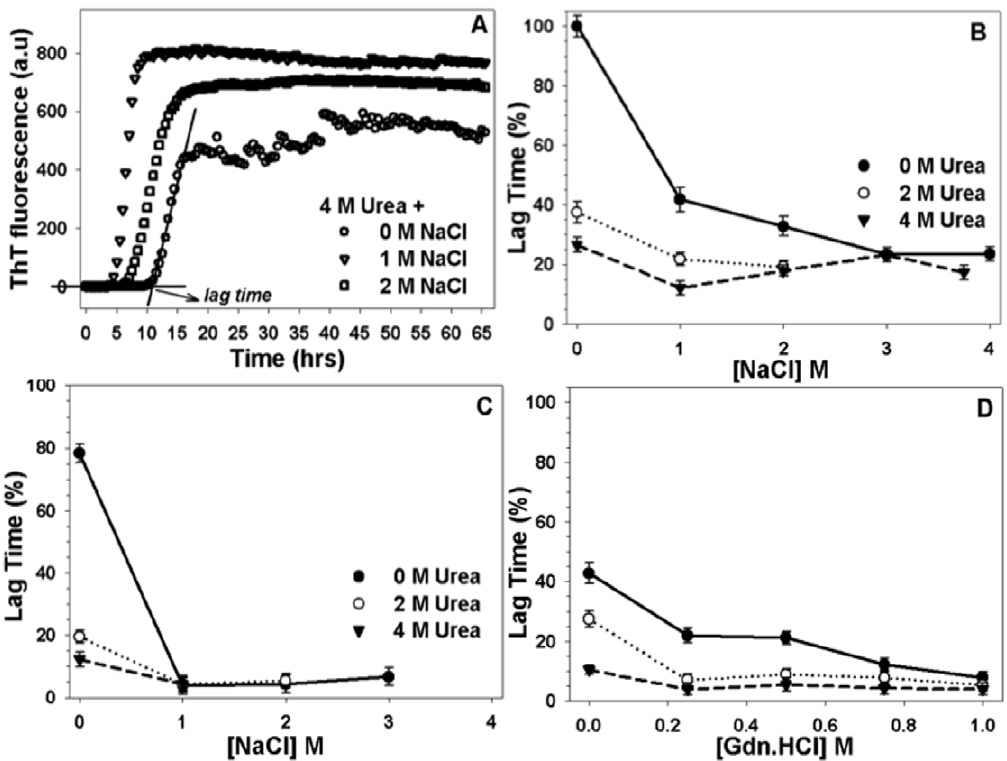
Figure 1. Kinetics of insulin fibrillation. Panel A shows representative sigmoidal curves of insulin fibrillation obtained at increasing NaCl concentrations in the presence of 4 M urea pH 7.4. The profiles are a plot of ThT emission max at 482 nm with respect to time. Panel B shows changes in the lag time of insulin fibrillation obtained from ThT plots at increasing NaCl concentrations in the presence of either 0 M (circles), 2 M (inverted triangles) or 4 M urea (squares) at pH 7.4. Panel C exhibits changes in the lag time with increasing NaCl concentrations in the presence of either 0 M (circles), 2 M (inverted triangles) or 4 M urea (squares) at pH 2. Panel D shows changes in the lag time with increasing Gdn.HCl concentrations in the presence of either 0 M (circles), 2 M (inverted triangles) or 7 M urea (squares) at pH